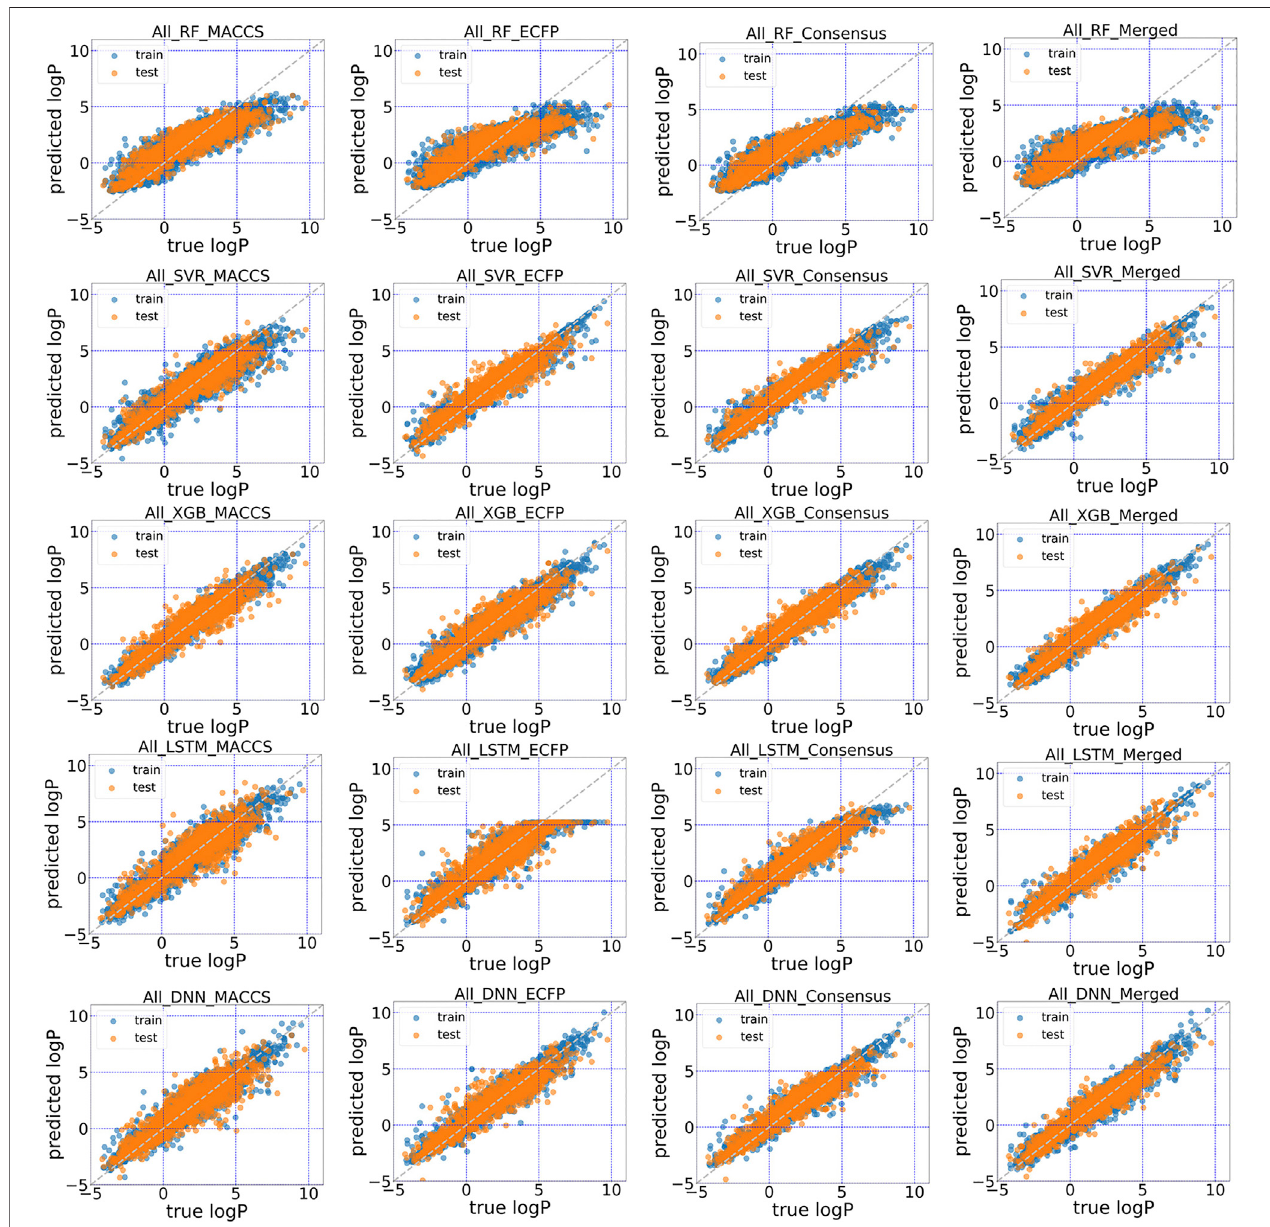
FIGURE 5 | Scatter plot of the predicted logP vs. stored data in “ All ” dataset of DrugBank for fi ve models with MACCS, ECFP, consensus model and the conjoint fi ngerprints.